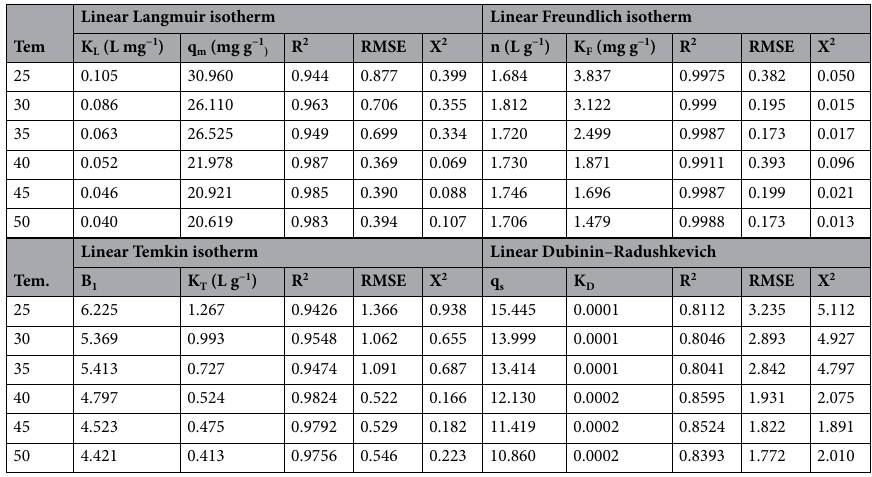
Table 7. Information of linear isotherm models for RR 198 adsorption onto MSW compost